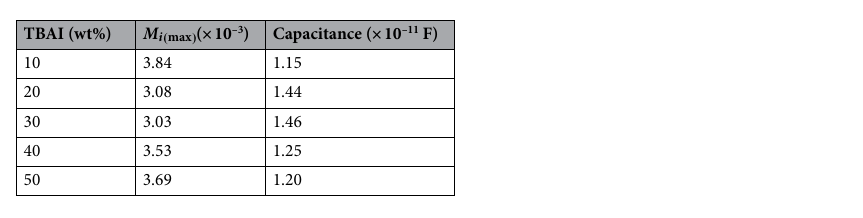
Table 4. Measured capacitance for various wt% of TBAI